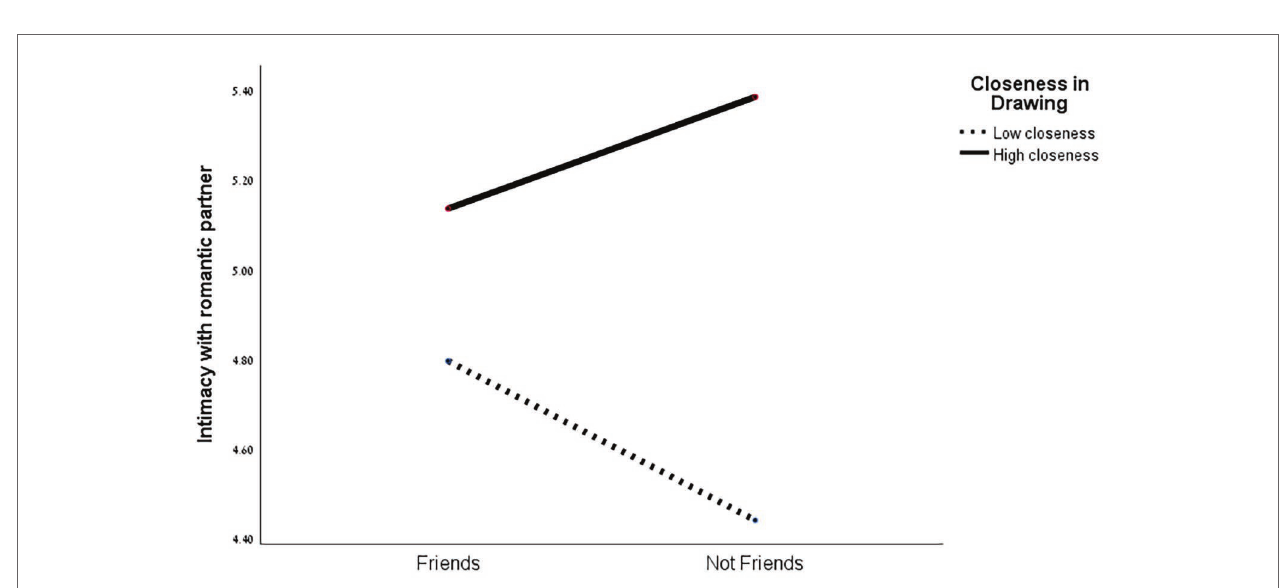
FIGURE 6 | Intimacy with romantic partner in adulthood and closeness in drawing (in